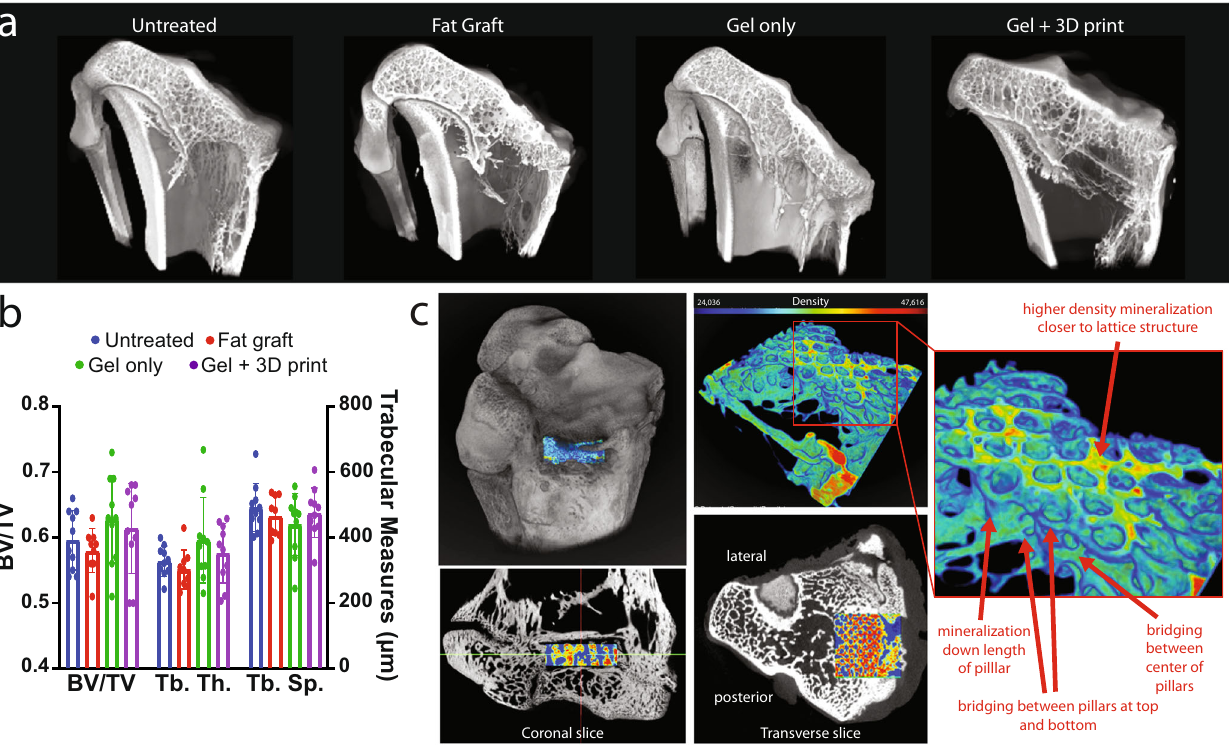
Fig. 8 MicroCT assessment at 8 weeks post treatment. a Representative microCT images of all treatments clipped at mid-plane to expose a cross-section of the injury site. b Bone analysis of all treatment limbs highlighting lack of signi fi cant differences across any measure between treatments. Data represent mean ± standard deviation (error bars). c Representative Gel + 3D print specimen with the composite region highlighted with a LUT based on density (scaffold attenuation will appear black in gray scale or dark blue in LUT). Panels show 3D view, coronal slice, transverse slice, and ROI of the gel + 3D print (cropped to show interior of scaffold excluding lattice). Inset highlights mineralization patterns within the scaffold including higher mineralization towards the lattice structure (top and bottom). There was also mineralization down the length of the pillars but bridging between pillars was less